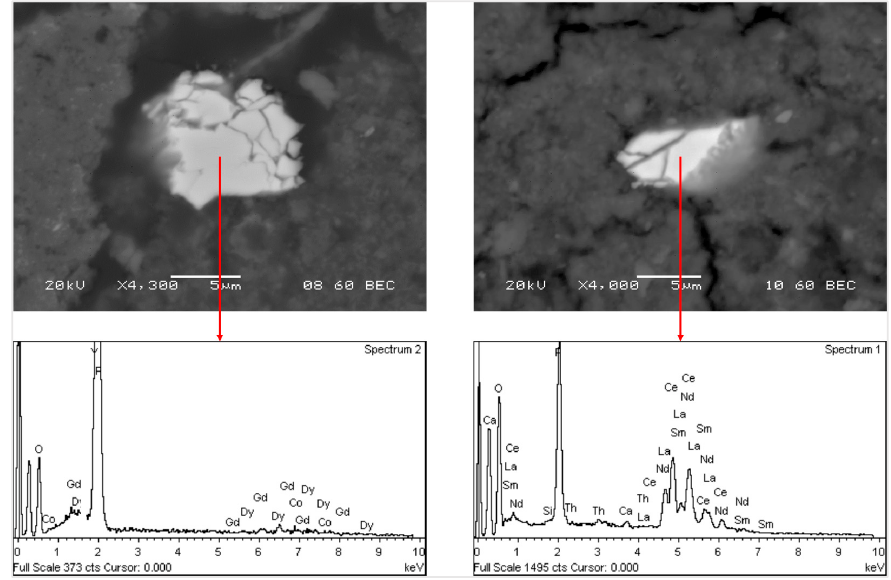
Figure 9. SEM image of a YPO 4 particle ( left ) and a CePO 4 particle ( right ).